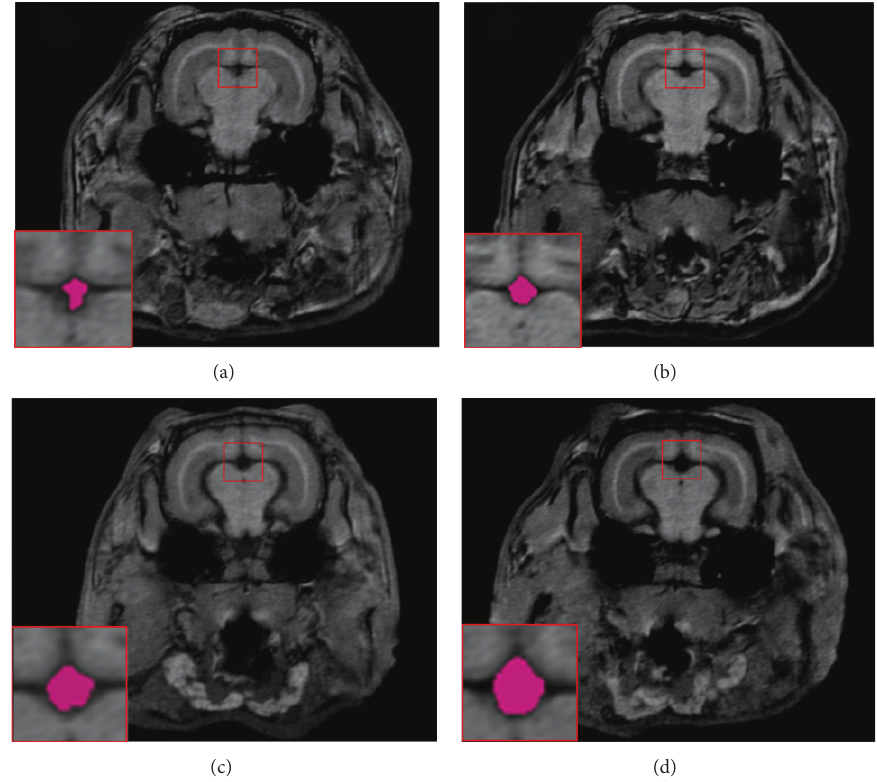
Figure 4: Structural MRI scan of a rabbit that received normal chow and distilled drinking water (a), normal chow and 0.12 ppm copper added to the distilled drinking water (b), 2% cholesterol and distilled drinking water (c), or 2% cholesterol and copper added to the distilled drinking water (d). The inset shows the area around the third ventricle in each rabbit and the red shading illustrates the significantly larger area of the third ventricle for cholesterol-fed rabbits ((c) and (d)) compared to the chow-fed control rabbits ((a) and (b)). The data show significant increases in the area of the third ventricle as a function of being fed cholesterol. Data are modified from